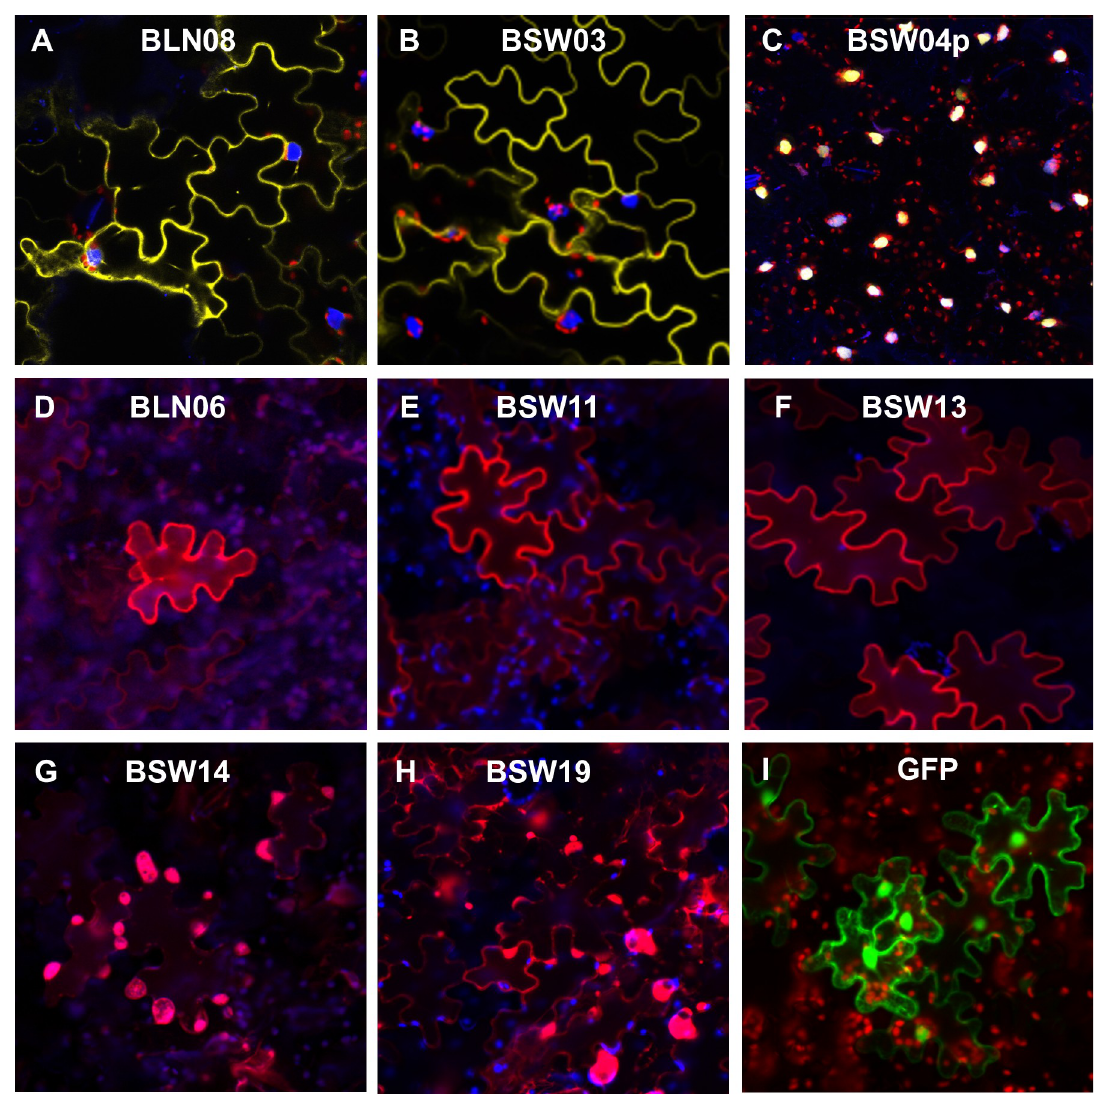
Fig 5. Confocal microscopy of fluorescently-tagged WY containing candidate effectors from B . lactucae transiently expressed in lettuce. Panels A-C show N-terminal YFP-tagged effectors (yellow), DAPI nuclear stain (blue), and chlorophyll autofluorescence (red). Panels D-H show N-terminal mCherry-tagged effectors (red) and chlorophyll autofluorescence (blue). Panel I shows free GFP (green) and chlorophyll autofluorescence (red). All squares are 200 x 200 μ M.